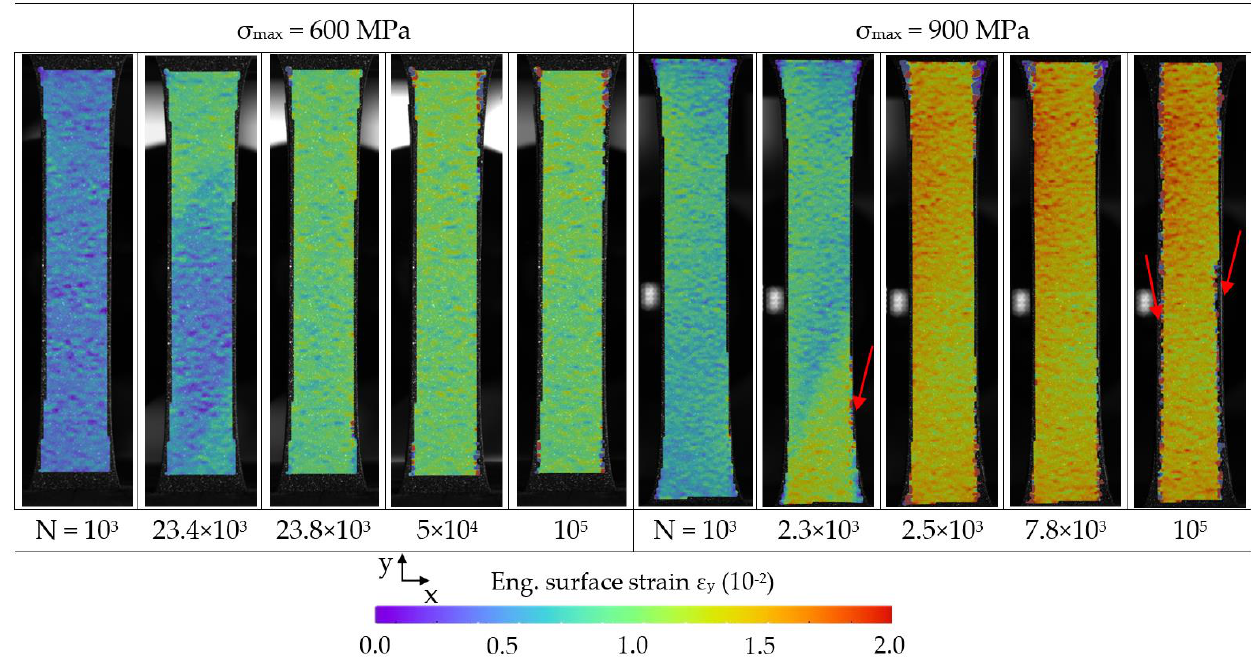
Figure 12. DIC strain measurement during CAT with σ max of 600 and 900 MPa on the surface of the hybrid laminate in 1/2-configuration of 1.4310 and carbon fiber reinforced PA 6. Selected cycles are shown, visualizing the strain development before and after 1.4310 failure as well as fiber failure at the edges of the laminate (red arrows).